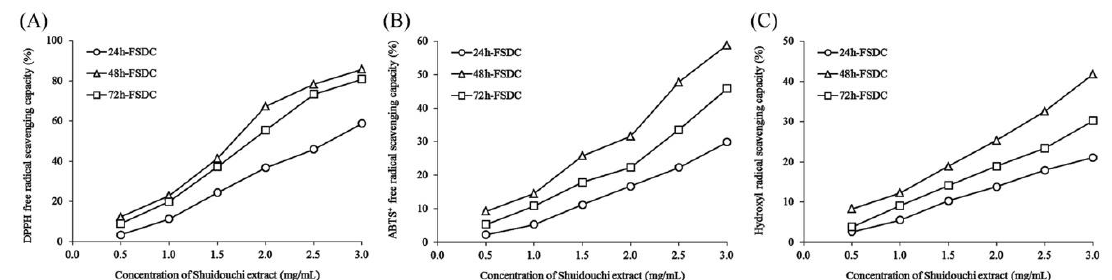
Figure 6. DPPH ( A ), ABTS + ( B ), and hydroxyl ( C ) free radical scavenging capacity of Shuidouchi with different fermentation durations. 24h-FSDC: 24 h fermented Shuidouchi; 48h-FSDC: 48 h fermented Shuidouchi; 72h-FSDC: 72 h fermented Shuidouchi. Table 7. DPPH (A), ABTS + (B), and hydroxyl (C) free radical scavenging capacities of Shuidouchi extract fermented for different durations.